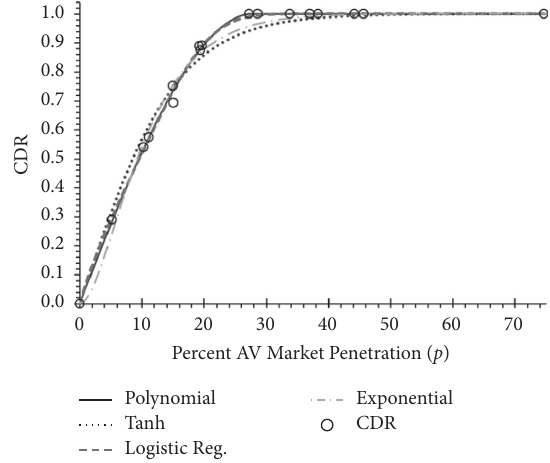
Figure 5: AV market penetration versus CDR